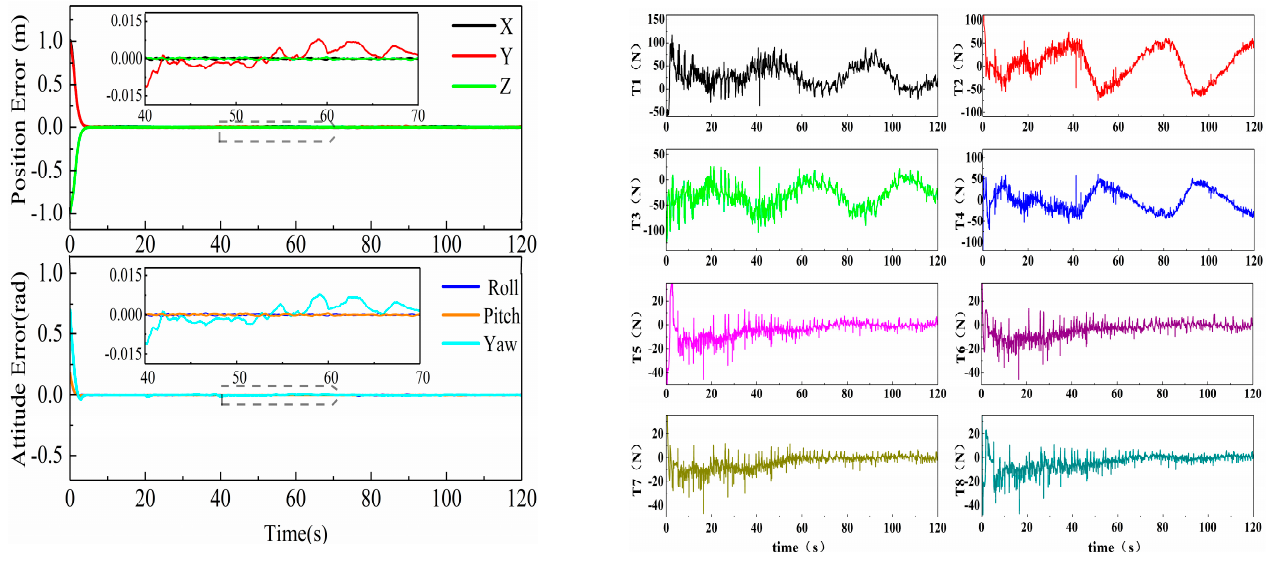
Figure 4. The control effect of FTESO − FTC − PAM under Case 2.